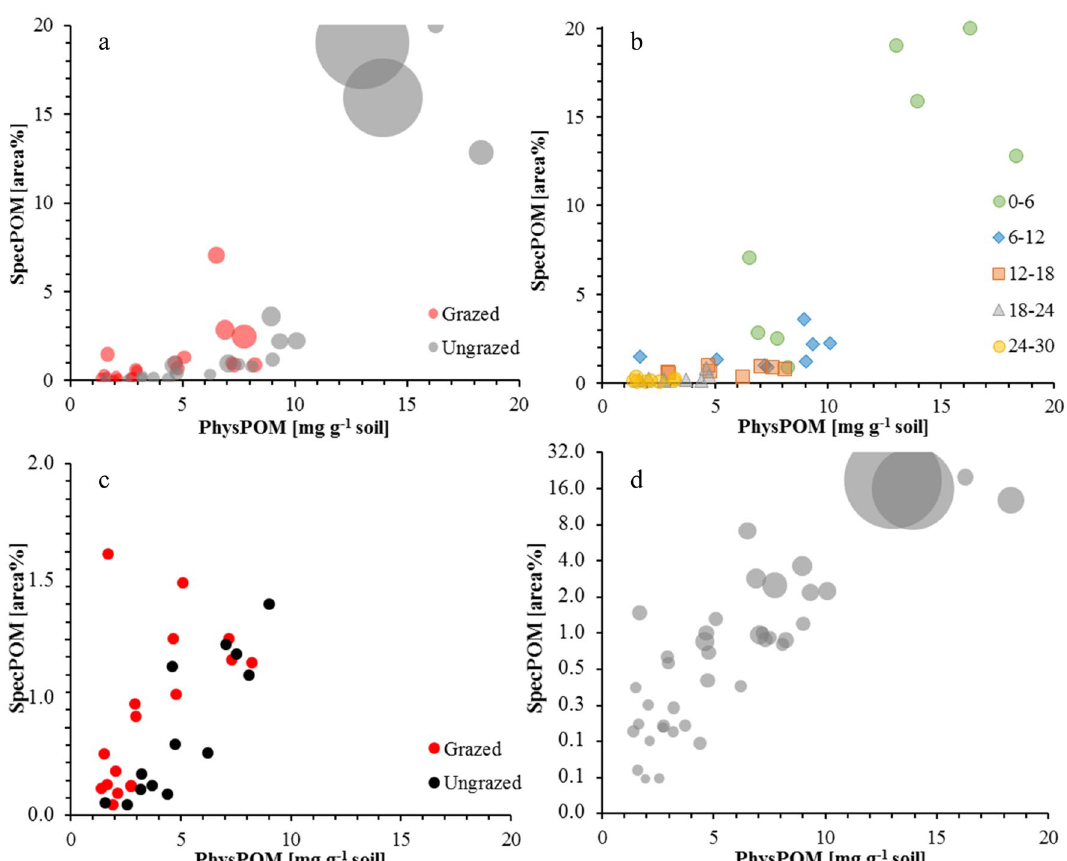
Figure 5. Scatter plots illustrating correlations between the amount of organic carbon in physically isolated particulate organic matter fractions (PhysPOM) and spectroscopically identified organic matter dominated pixels in hyperspectral images (SpecPOM). Bubblesize in parts a and d correspond to the size of the organic particles as identified in the hyperspectral images using segmentation images. Part a shows the correlation as affected by management, part b as affected by sampling depth, part c shows the correlation as affected by management without the four 0–6 cm samples from the ungrazed profiles, and part d illustrates the correlation for all samples as affected by management with a log-scaled y-axis for the